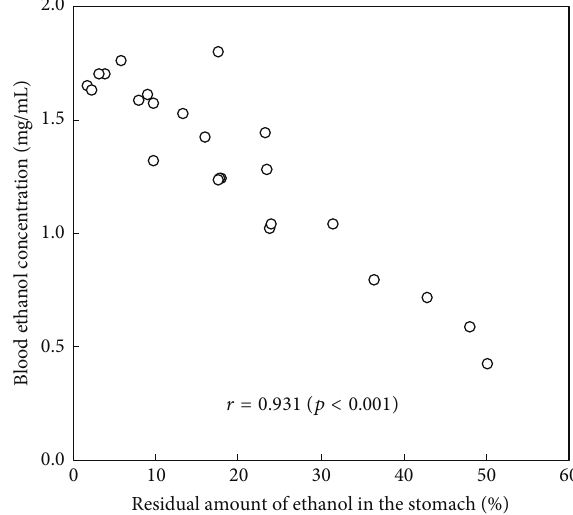
Figure 5: The correlation between the blood ethanol concentration and residual amount of ethanol in the stomach 2h after ingestion of 2.0 g/kg ethanol after the administration of each sample in Experiment 3. Results represent the values of each rat ( 𝑛 = 24 ) and the correlation coefficient ( 𝑟